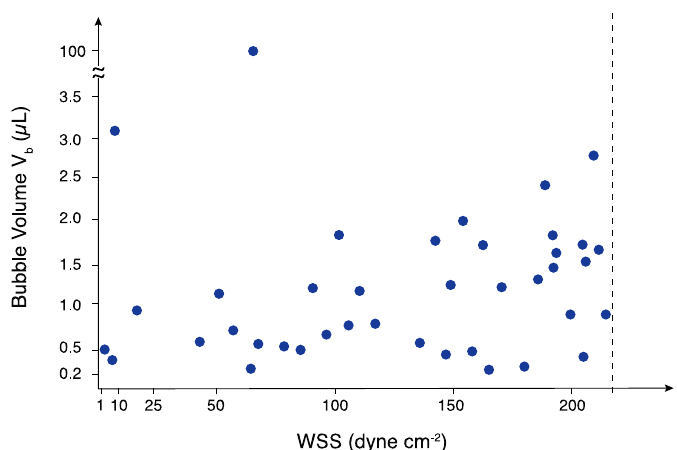
Figure 3. RID module bubble removal results at flow rates corresponding to defined WSS in a microfluidic channel. Each data point represents air bubbles successfully removed from a segmented air-liquid flow with bubble volume V b . The dashed line represents the lower bound of the 95% confidence interval for successful device operation (WSS = 213 dyne cm − 2 , Q = 2.6 mL min − 1 ). Air bubbles ranging from 200 nL to 100 µ L were successful removed and the maximum air removal rate (dV / dt) max = 1.5 mL min − 1 . RID is operational across the physiological WSS range needed for in vitro shear stimulation studies using both human and rodent